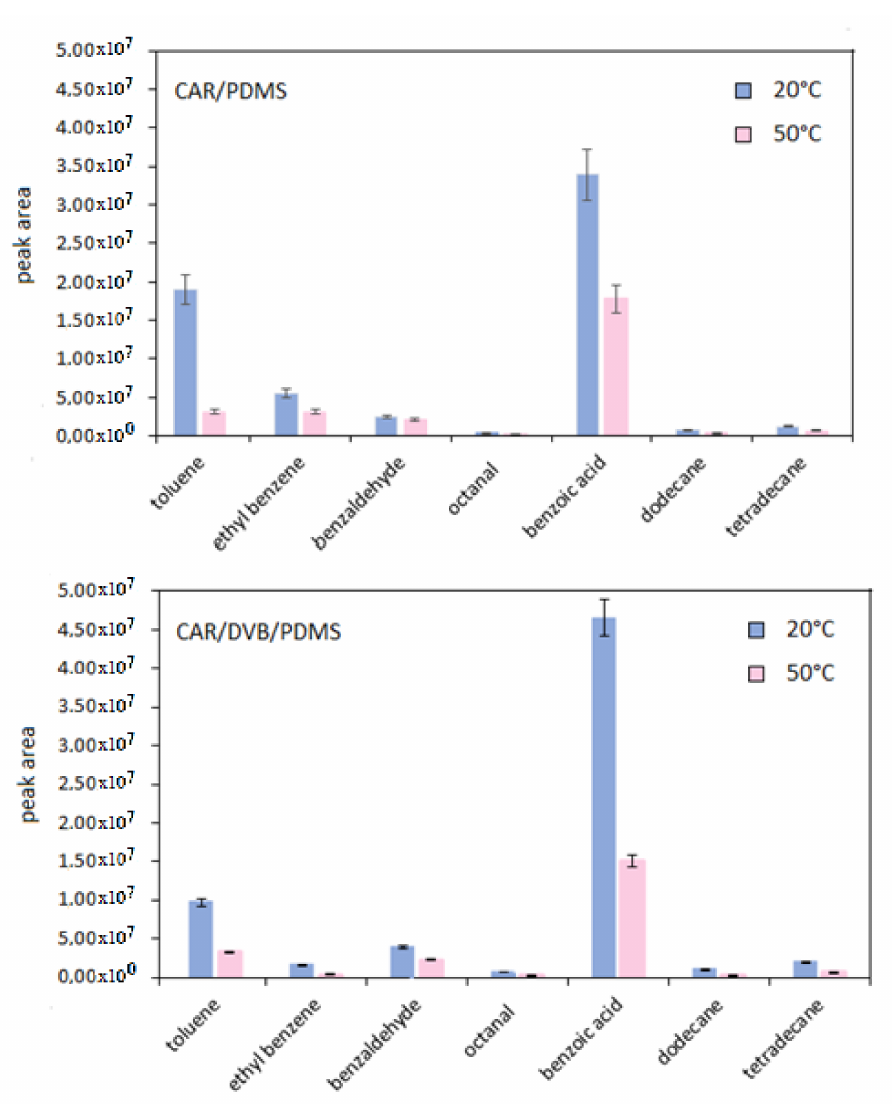
Figure 4. Effect of the temperature on the DI extraction efficiency obtained with both selected fibers. As can be easily inferred from the results obtained so far, the CAR/DVB/PDMS fiber showed the best extraction efficiencies for almost all the analytes and was then selected for the prosecution of the experiments. Figure 5 reports the extraction time profiles obtained with the CAR/DVB/PDMS fiber at room temperature in the presence of 30% NaCl. Equilibrium was reached after 45 min for toluene and ethylbenzene, while longer sampling times were required for the other analytes. However, considering that non- equilibrium extractions can be performed working under reproducible conditions, 60 min were selected as the best compromise between time and